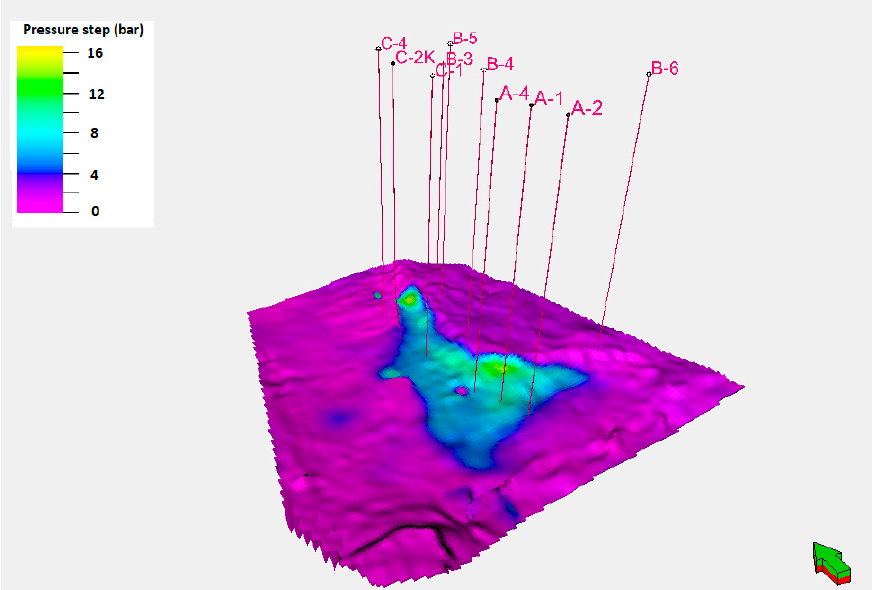
Figure 23. Distribution of pressure steps between the sealing anhydrite interval and the top of the reservoir rock at the end of CO 2 injection.